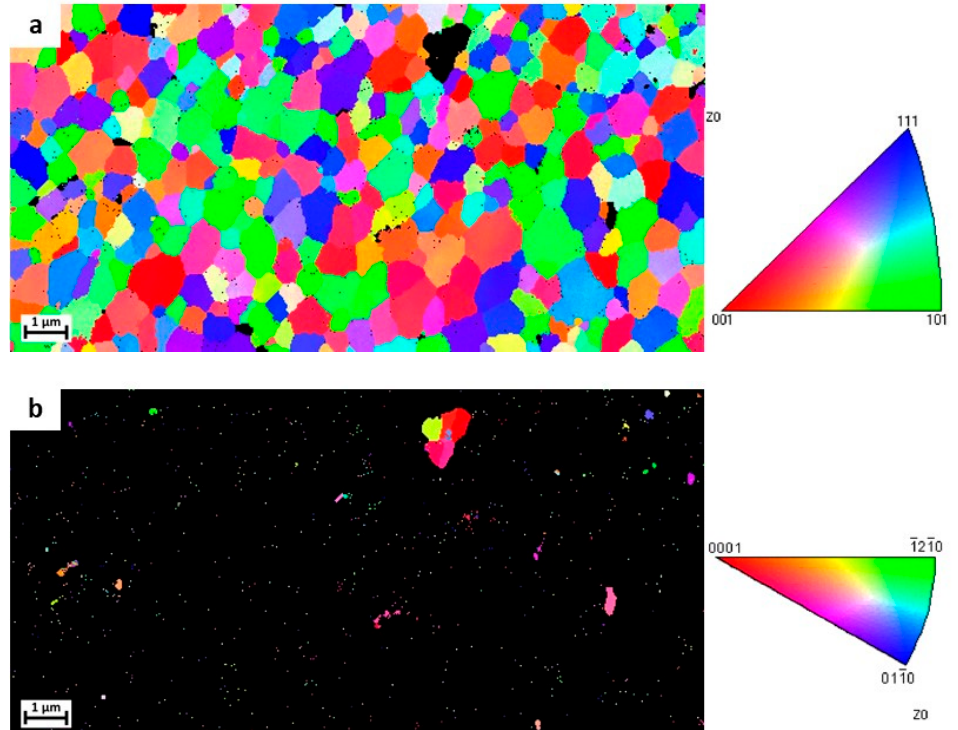
Figure 3. EBSD orientation maps of ( a ) α -Al and ( b ) TiB 2 phases.